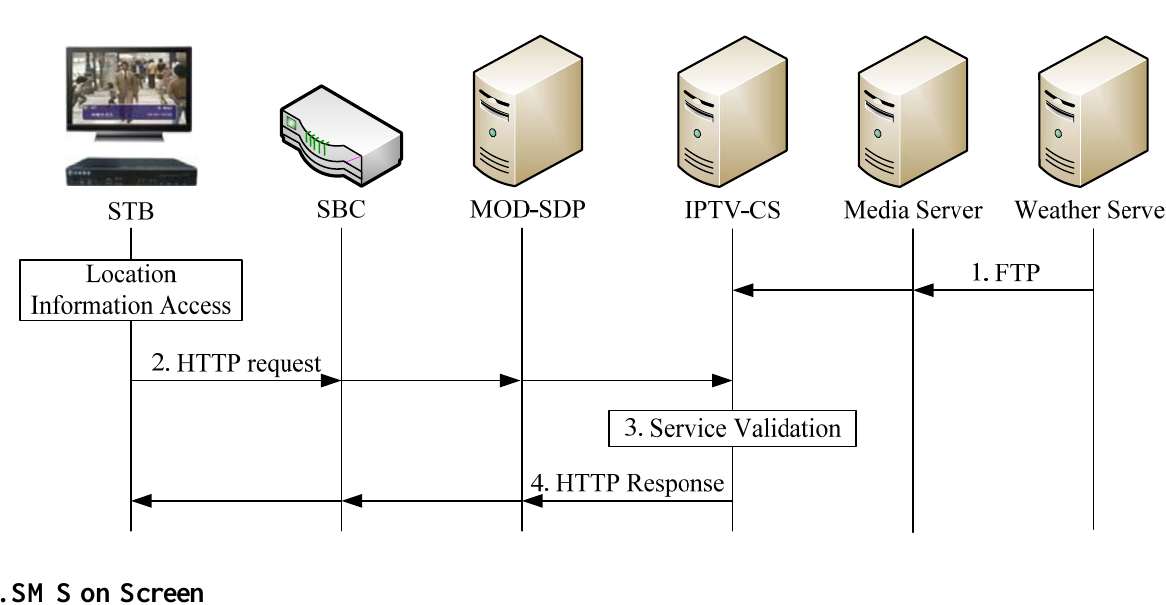
Figure 6. Message flow of the weather